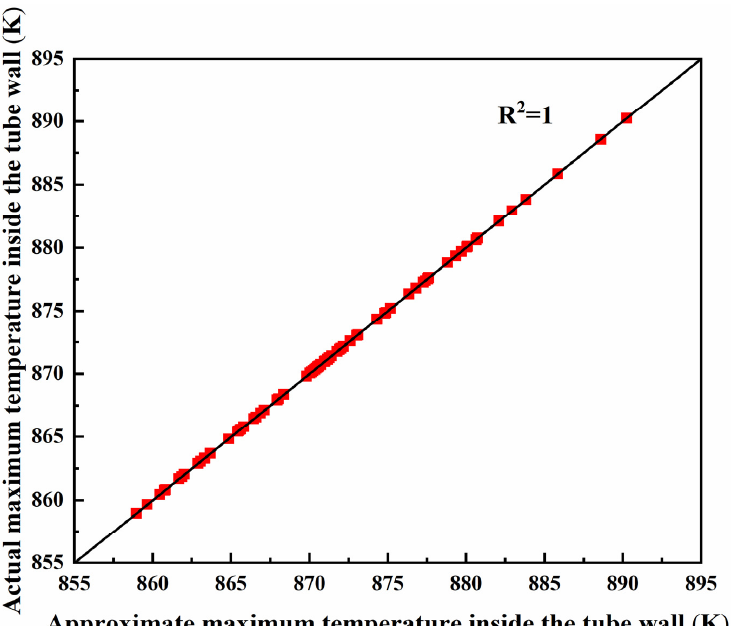
Figure 4. Error analysis results of the maximum temperature inside the tube wall as the model output.